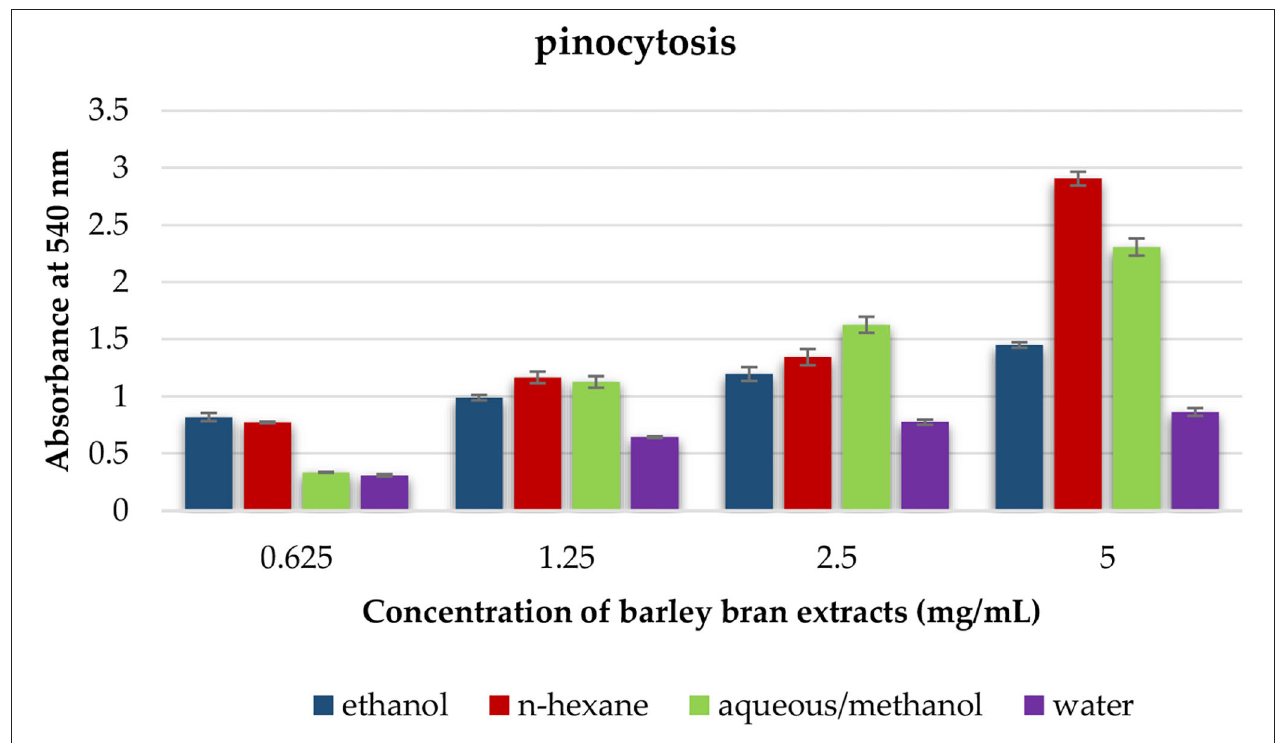
FIGURE 5 | The effect of barley bran different extracts on macrophage pinocytosis.